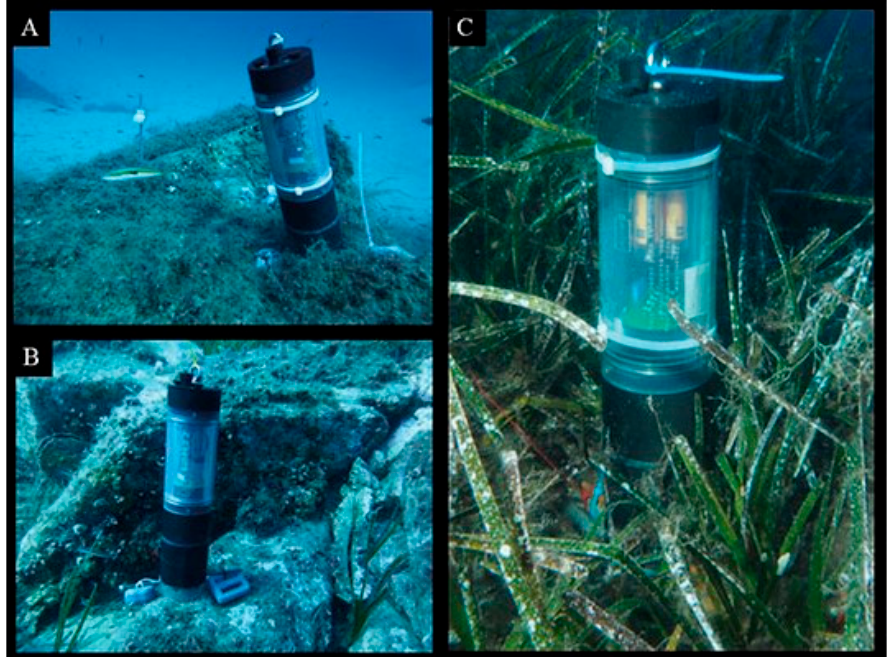
Figure 2. Eureka Manta-2 multi-probes deployed at 28 m depth in Phyllophora crispa mats ( A ), hard- bottom habitats ( B ), and within the Posidonia oceanica seagrass meadows ( C ). Photos taken by Alice G. Bianchi.